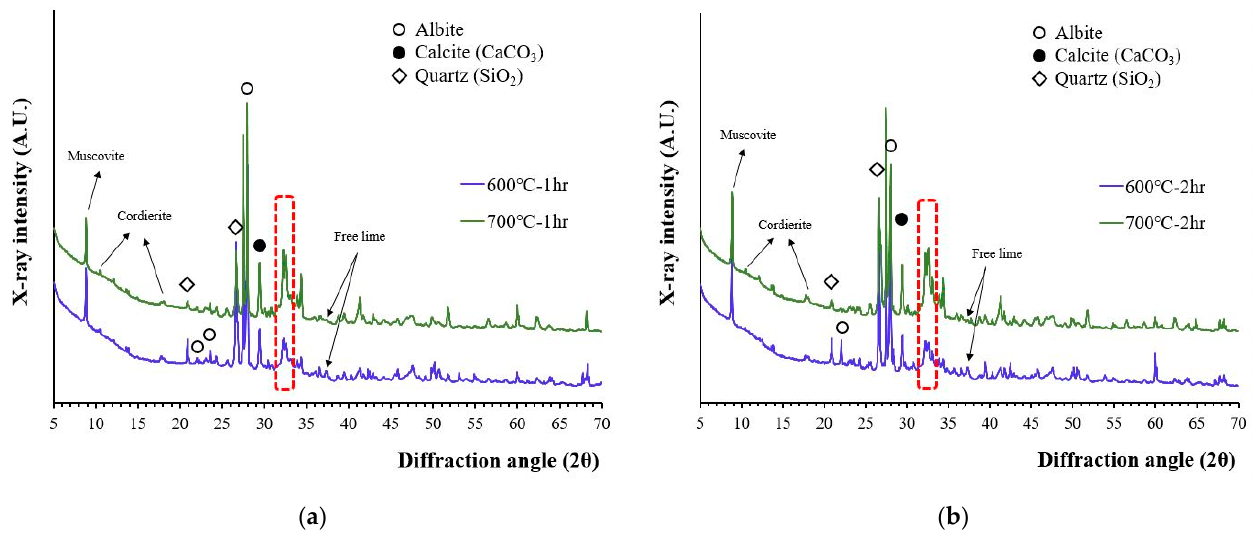
Figure 1. The XRD patterns of recycled cement powder heat treated at 600 and 700 °C: ( a ) for 1 h; and ( b ) for 2 h. and ( b ) for 2 h.